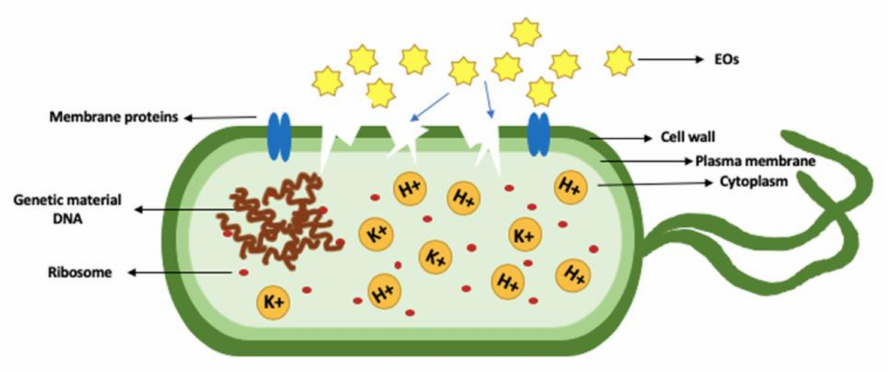
Figure 1. Membrane disruption in a bacterial cell caused by EO leading to the inhibition of bacterial growth. K+ is potassium ion and H+ is hydrogen ion.